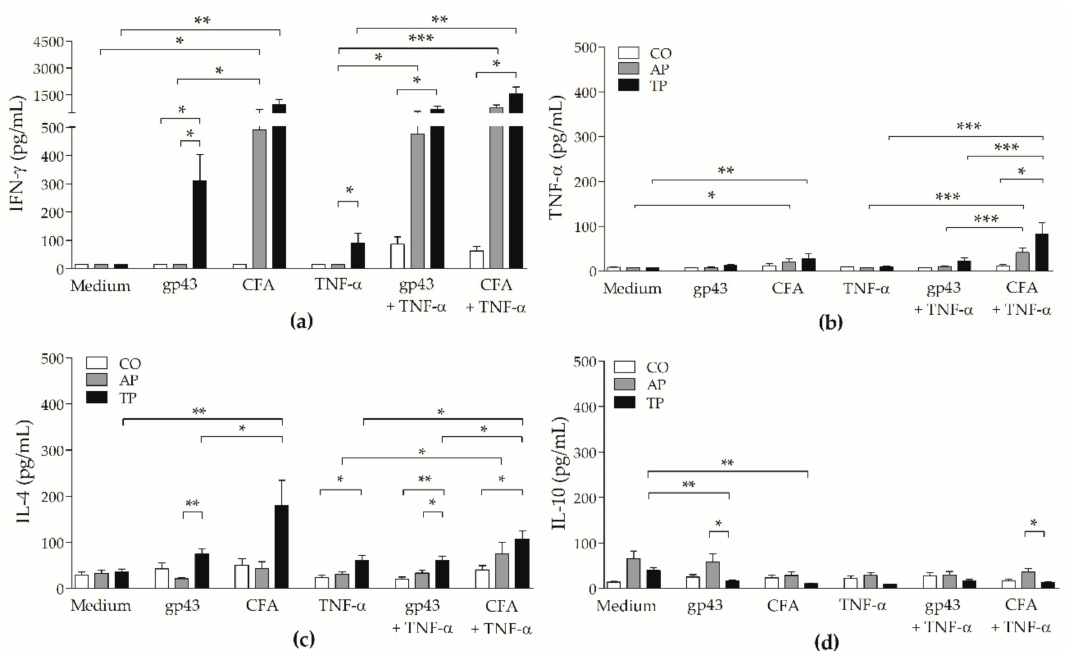
Figure 6. Influence of gp43- and CFA-stimulated moDCs on secretion of cytokines in cocultures with autologous lym- phocytes. ELISA-assayed levels of ( a ) IFN- γ , ( b ) TNF- α , ( c ) IL-4 and ( d ) IL-10 (pg/mL) were measured on cocultures of autologous lymphocytes and moDCs of non-PCM control subjects (CO: white bars; n = 15), and patients with active PCM (AP: grey bars; n = 17) or treated PCM (TP: black bars; n = 22) previously stimulated with gp43 or CFA, with or without TNF- α , or left untreated (Medium), after 144 h. Results expressed as means with SEM of levels, and capped lines indicate statistically significant differences with respective p values: * p < 0.05, ** p < 0.01, or *** p <